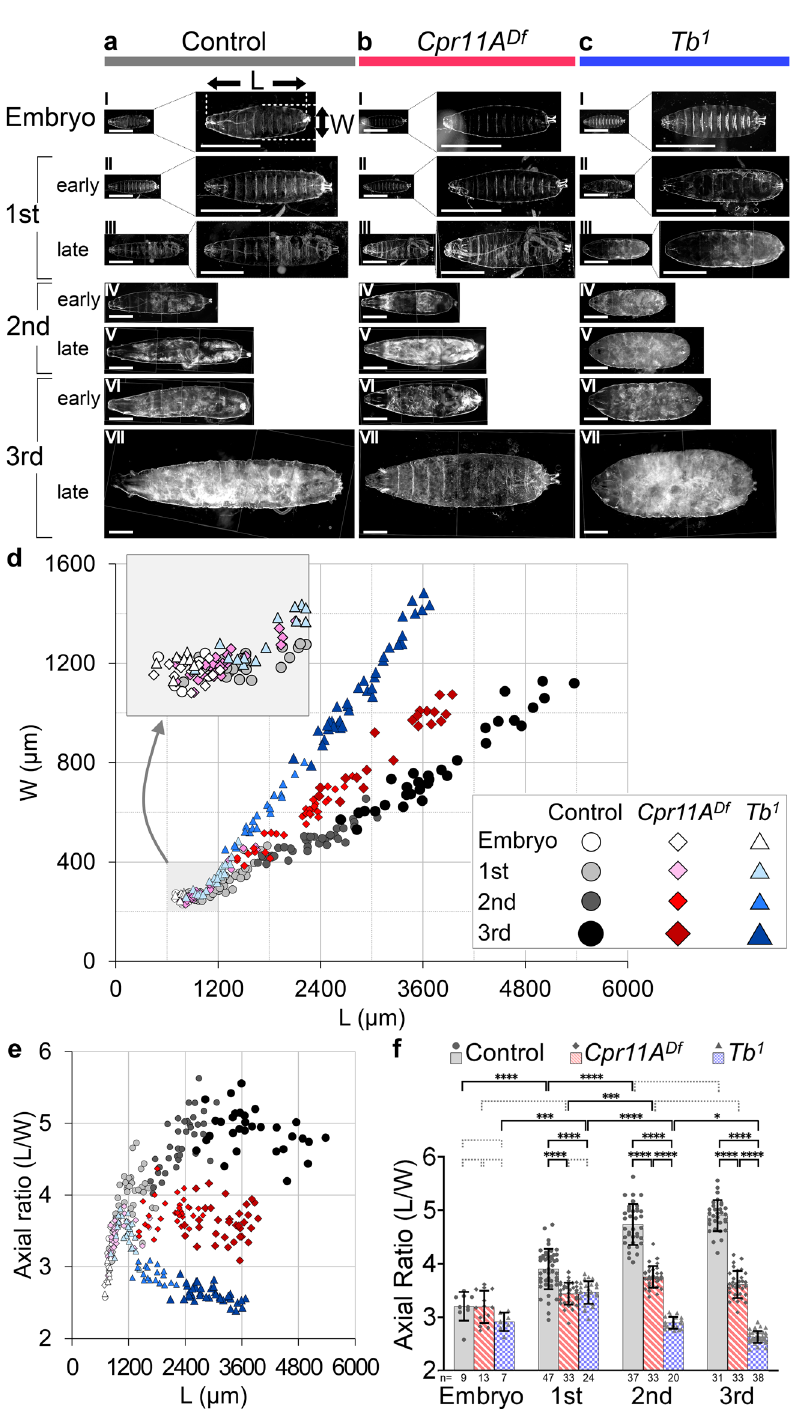
Fig. 2 Cuticle expansion during larval growth. a – c Larval cuticles of the control ( a ), Cpr11A Df ( b ) and Tb 1 ( c ) at embryonic stage 17d (I), early/late fi rst instar (II/III), early/late second instar (IV/V), and early/late third instar (VI/VII). In (I-III), magni fi ed images are shown on the right. Cuticles are viewed from the ventral sides. Anterior is to the left. L, cuticle length; W, cuticle width. Bars, 500 μ m. d Plot of cuticle length (L) versus cuticle width (W). 1st, fi rst instar; 2nd, second instar; 3rd, third instar. e Plot of cuticle axial ratio (L/W) versus cuticle length (L), calculated from the data in d . f Mean ± S.D. of axial ratios for each developmental stage, calculated from the data in ( d ). n, the number of embryos or larvae measured for each genotype for each stage. Signi fi cance was assessed using two-way ANOVA ( p < 0.0001) and Tukey ’ s multiple comparisons test. * p < 0.05; ** p < 0.01; *** p < 0.001; **** p < 0.0001; broken brackets, not signi fi